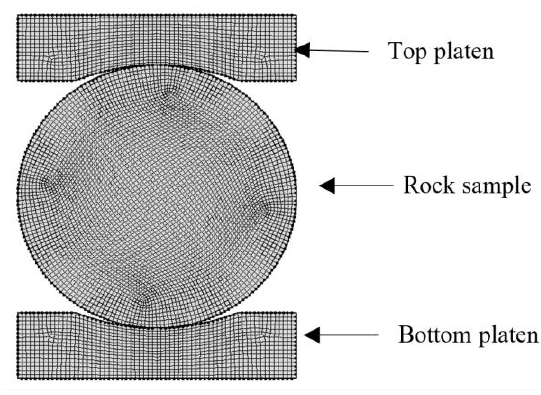
Table 2. Simulation Input Parameters.